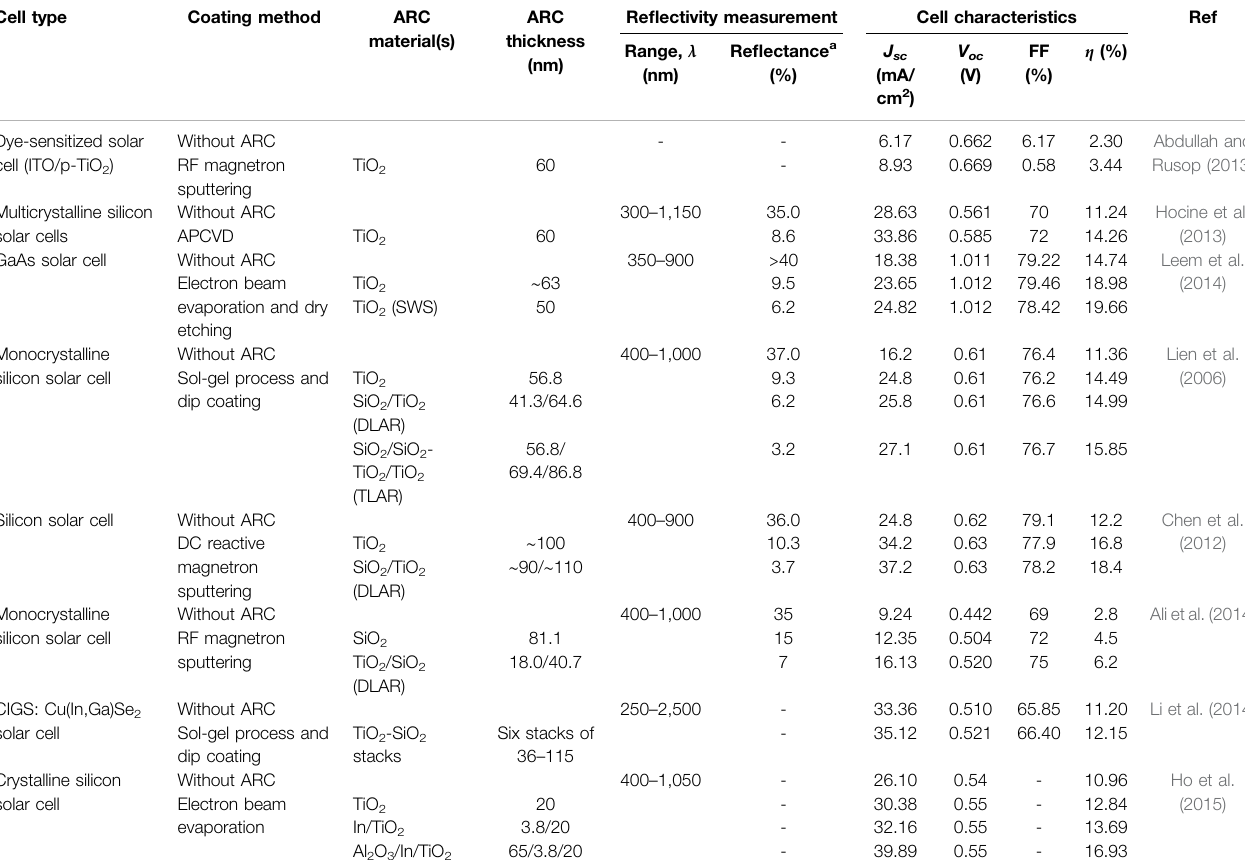
TABLE 1 | Notable achievements in the development of TiO 2 -based antire fl ective coatings (ARCs) and fi gures of merit showing the resulting enhancement in solar cells ’ performance. Cell